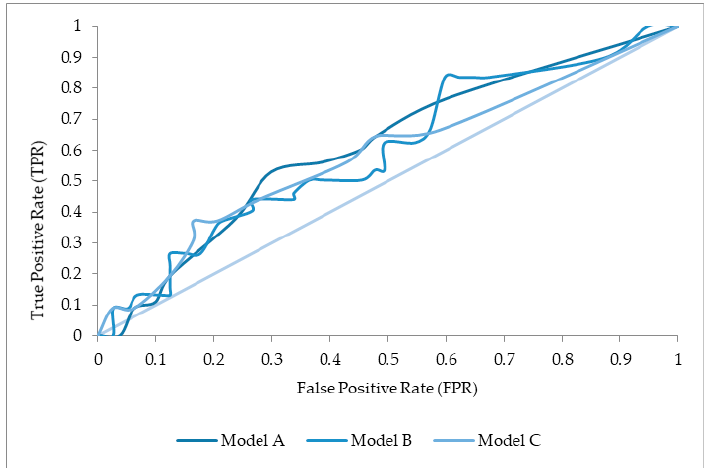
Figure 16. Deducted ROC graph from the models A, B, and C.